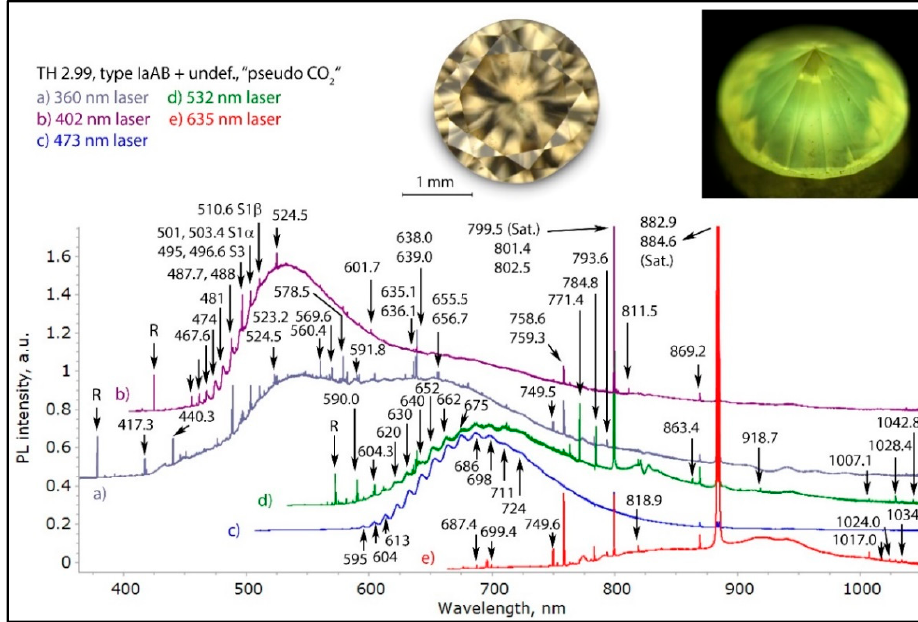
Figure 9. The highly complex PL spectra of a Pseudo CO 2 diamond (TH 2.99) under five different laser excitations. The yellow PL seen in the photo is caused mainly by the S1 and S3 defect. The complex band centered at about 690 nm with all its oscillating peaks separated by 10 to 12 nm each seen in trace ( c ) and ( d ) is very typical for diamonds rich in oxygen, and it relates directly to the 480 nm absorption band. Such diamonds always contain nickel as well, as can be seen by the presence of S1 and S3, the very strong 882.9 / 884.6 nm Ni i + doublet as well as many of the sharp features seen in the spectra. The PL spectra of CO 2 and Pseudo CO 2 diamonds are very similar and typical features present are identical. The spectra have been shifted vertically for clarity.